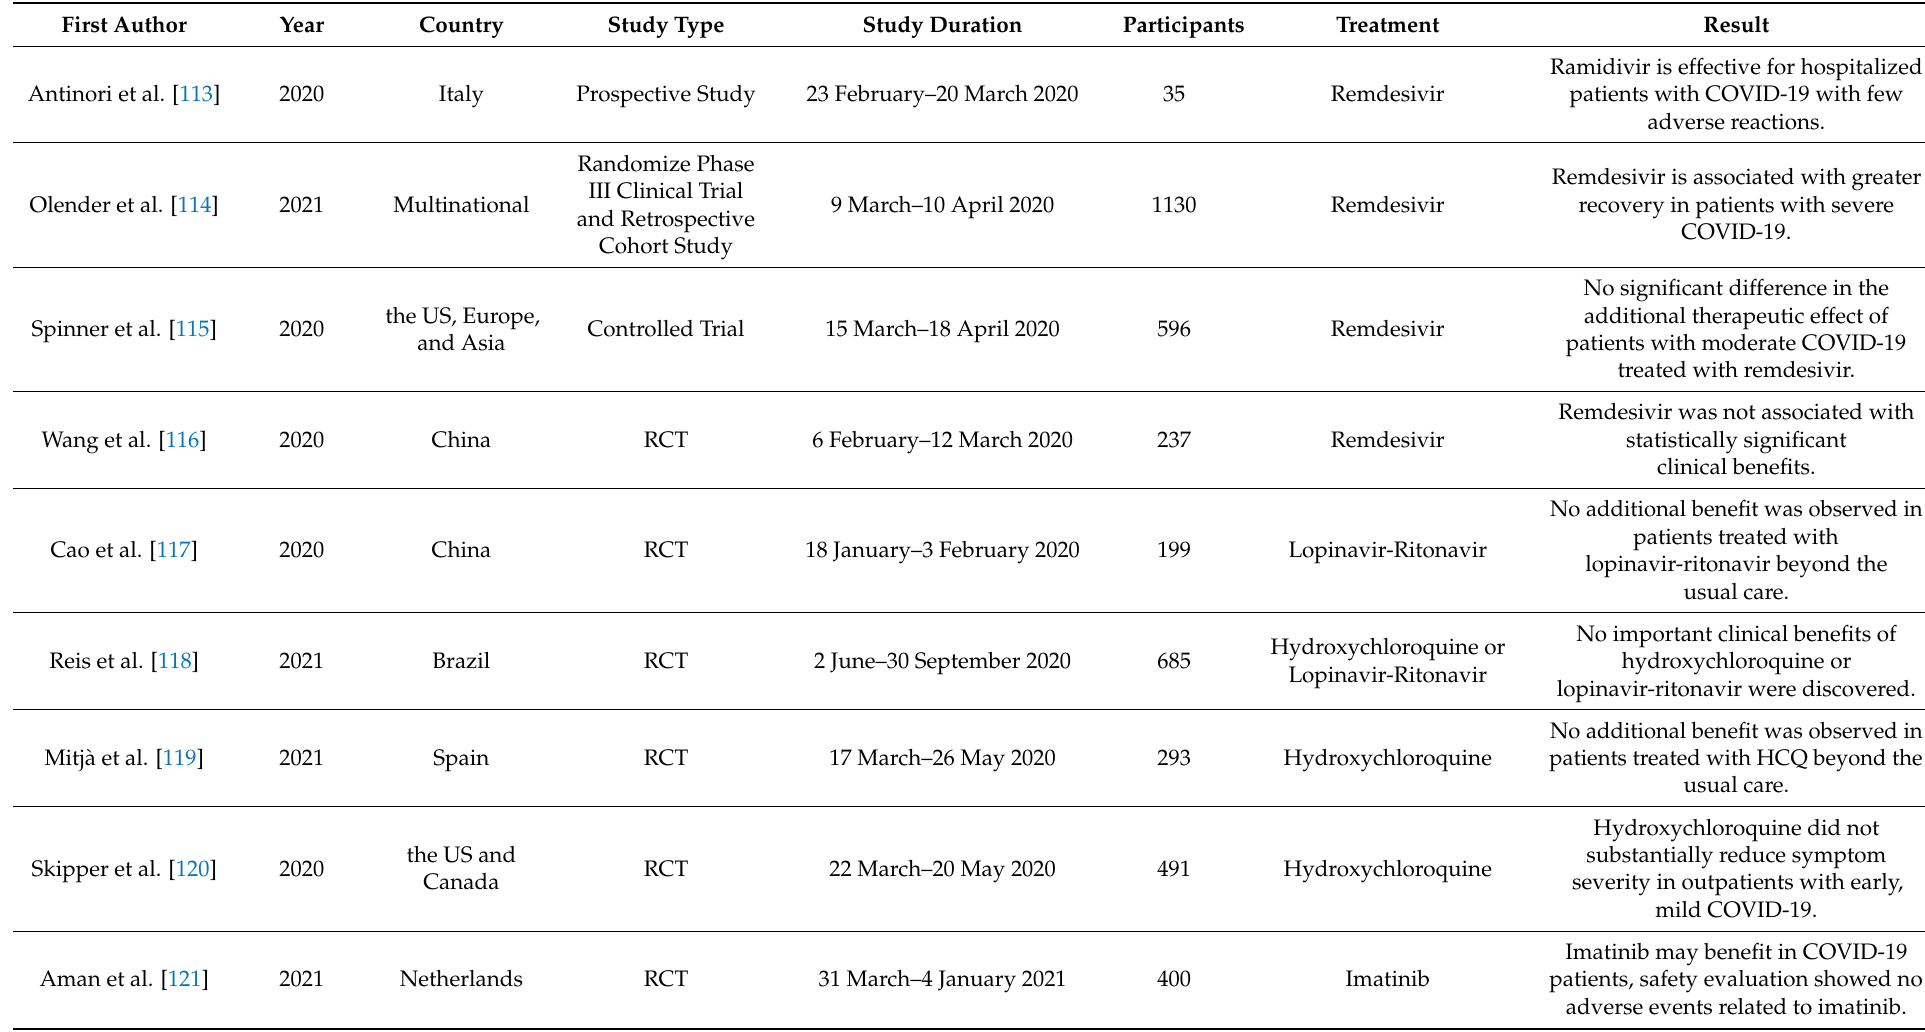
Table 1. Summary of Some Related Clinical Research